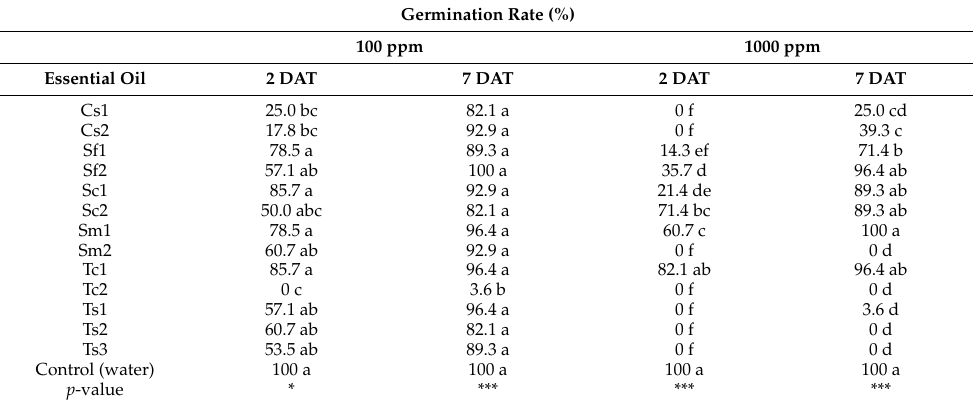
Table 3. Herbicidal effect of two doses of EOs on Lepidium sativum germination after 2 and 7 days of incubation (2 DAT and 7 DAT). Data are expressed as mean of three replicates in comparison with the control (100%).